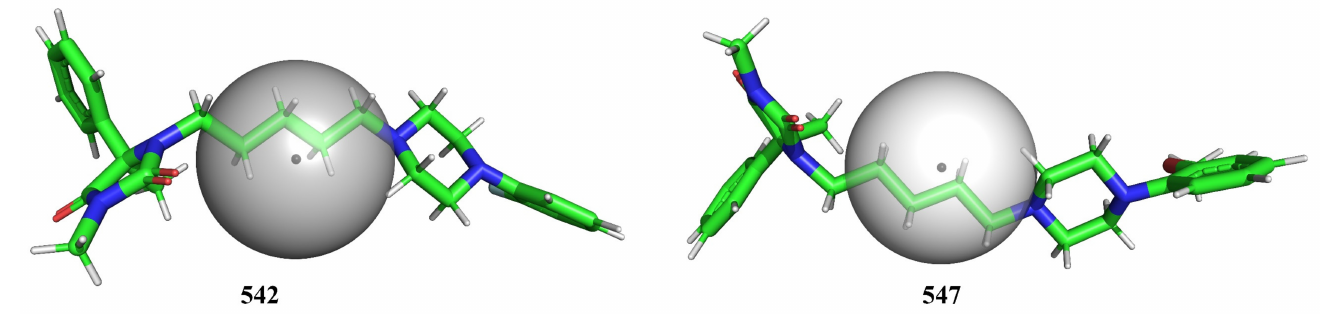
Figure 3. Depiction of com_Hhyd_3A using molecules 542 and 547 as representative examples (radius of gray sphere is 3